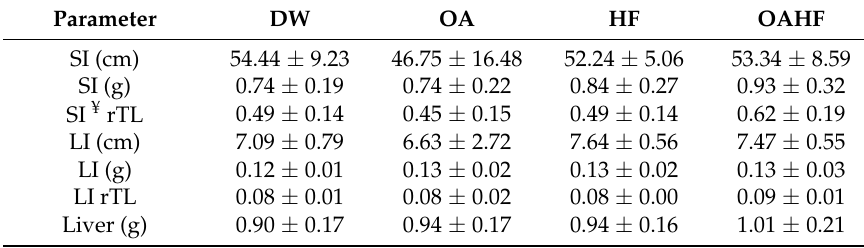
Table 2. The effect of neonatal oral administration of oleanolic acid on the lengths, absolute and relative weights of visceral organs in suckling male and female